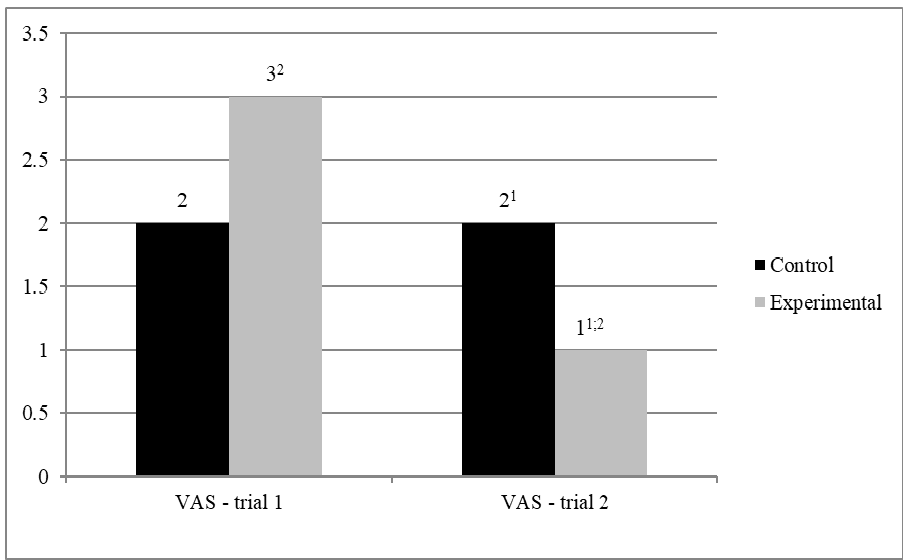
Figure 2. Average fear (VAS). 1—in the 2nd trial fear in the treatment condition was significantly lower than in the control condition ( p < 0.05). 2—significant difference between trial 1 and 2 in treatment condition ( p < 0.05).